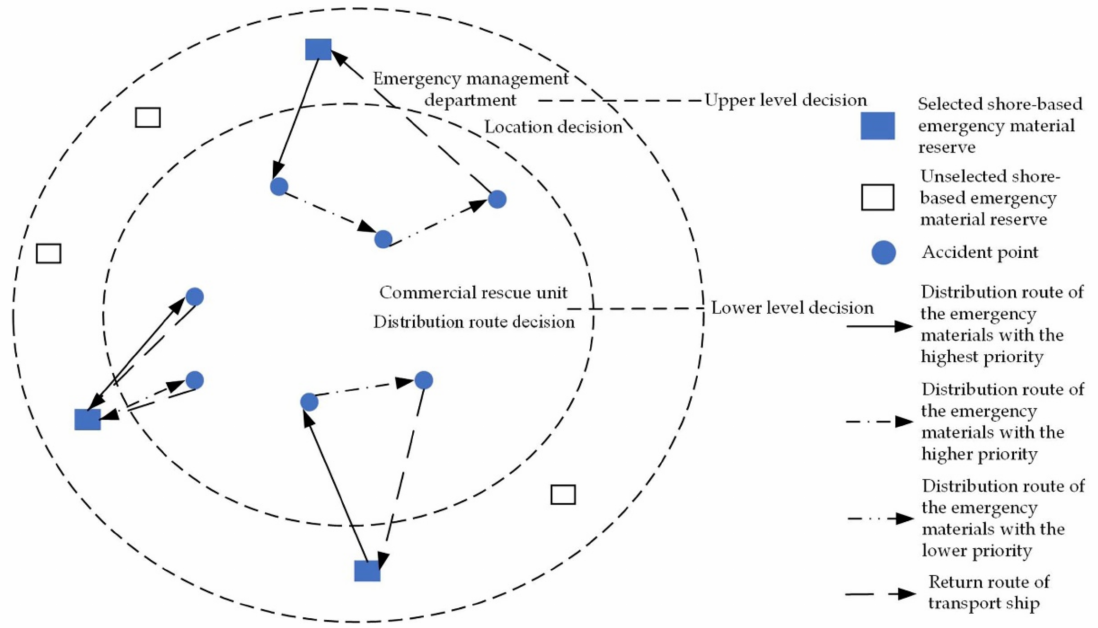
Figure 1. Schematic diagram of the maritime logistics system and related